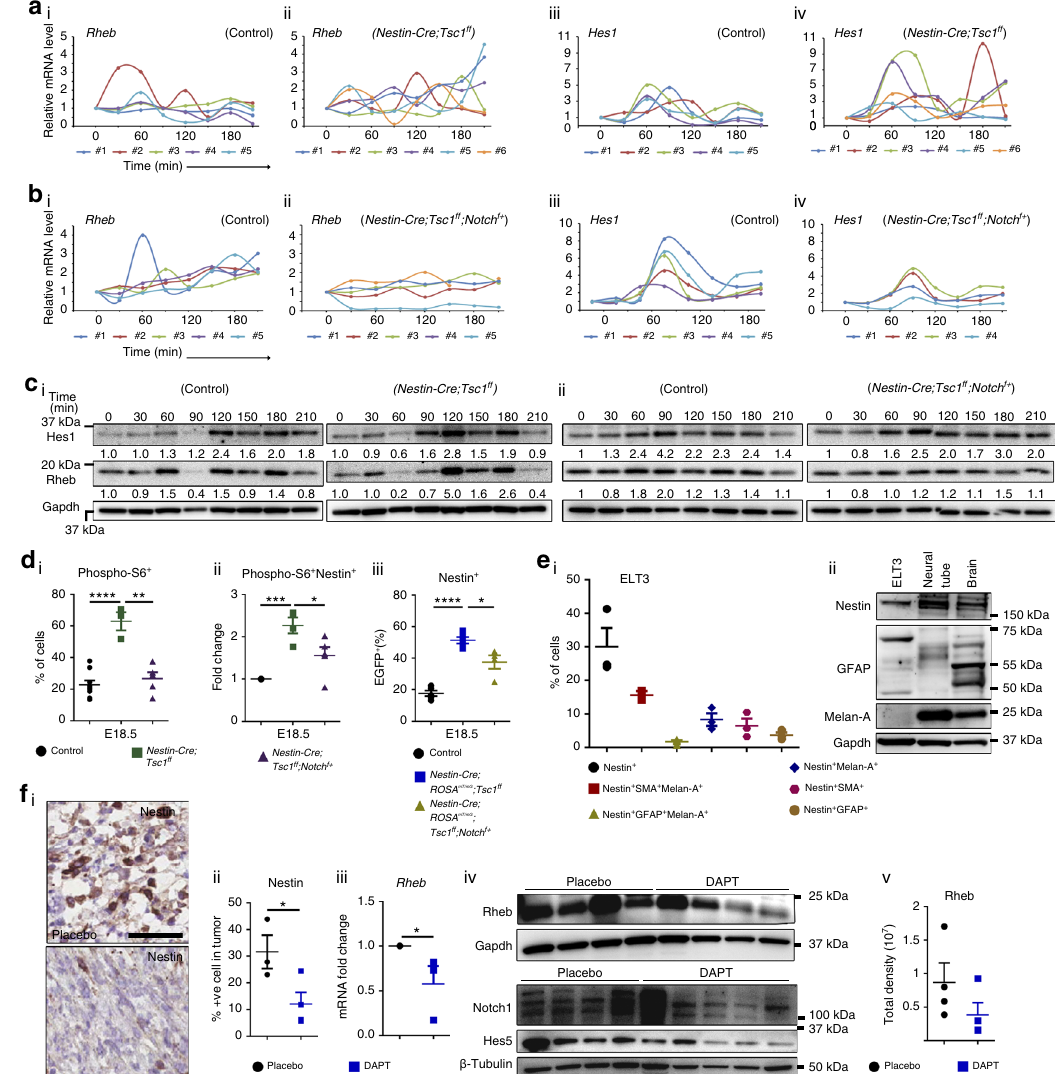
Fig. 6 Loss of Tsc1 leads to increased oscillation of Notch and Rheb. a , b q(RT)-PCR of (i, ii) Rheb and (iii, iv) Hes1 relative to Gapdh in NT cells from E15.5 littermate controls or a Nestin-Cre;Tsc1 ff or b Nestin-Cre;Tsc1 ff ;Notch f + embryos after release from synchronization. c The expression of Rheb and Hes1 in synchronized NT cells from E15.5 littermate controls or (i) Nestin-Cre;Tsc1 ff or (ii) Nestin-Cre;Tsc1 ff ;Notch f + embryos after release from synchronization by western immunoblotting. Numeric values represent densitometry analysis of the expression of Rheb or Hes1 relative to expression of Gapdh. d FACS of (i) phospho-S6 or (ii) phospho-S6 and nestin in NTs. d (i) percentage of phospho-S6 + cells in Nestin-Cre;Tsc1 ff and Nestin-Cre;Tsc1 ff ;Notch f + embryos relative to littermate control embryos ( Tsc1 ++ ;Notch ++ ), at E18.5. (ii) Fold changes in the percentage of phospho-S6 + nestin + NSCs in Nestin-Cre;Tsc1 ff and Nestin-Cre; Tsc1 ff ;Notch f + embryos relative to littermate control embryos ( Tsc1 ++ ;Notch ++ ) at E18.5. (iii) The percentage of NSCs (EGFP + nestin + ) within NTs from Nestin-Cre;ROSA mT/mG (control), Nestin-Cre;ROSA mT/mG ;Tsc1 ff , and Nestin-Cre;ROSA mT/mG ;Tsc1 ff ;Notch f + embryos at E18.5 (data from Nestin-Cre;ROSA mT/mG (control) and Nestin-Cre;ROSA mT/mG ;Tsc1 ff mouse embryos are also used in Fig. 5d(i, ii)). e (i) Percentages of ELT3 cells expressing nestin alone or co-expressing Melan-A, GFAP, and SMA by FACS. (ii) The expression of nestin, GFAP, and melan-A in ELT3 cells by western immunoblotting. f (i) Nestin expression in placebo- (top) and DAPT-treated (bottom panel) xenograft tumors. (ii) Quanti fi cation of results shown in f (i). (iii) q(RT)-PCR of Rheb relative to Gapdh . (iv) Rheb, Notch1 and Hes5 in placebo- ( n = 6) and DAPT-treated ( n = 5) xenograft tumors by western blot. (v) Quanti fi cation of Rheb expression shown in f (iv) by densitometry analysis after normalization to Gapdh. Data represent means ± s.e.m.. Error bars are de fi ned as means + s.e.m. * P ≤ 0.05 ’ ** P ≤ 0.01, *** P ≤ 0.001, **** P ≤ 0.0001 t- test. Data are representative of four, n control = 5 ( a (i)), n Nestin-Cre;Tsc1ff = 6 ( a (ii)), n control = 5 ( a (iii)), n Nestin-Cre;Tsc1ff = 6 ( a (iv)); three, n control = 5, n Nestin-Cre;Tsc1ff;Notchf+ = 5 ( b (i – iii)), n Nestin-Cre;Tsc1ff;Notchf+ = 4 ( b (iv)); two ( c ); three ( d , e ), n = 3 ( d (i, ii)), n = 4 ( e (i), d (iii)), n = 3 ( f (ii, iii)), n = 4 ( f (v)) independent